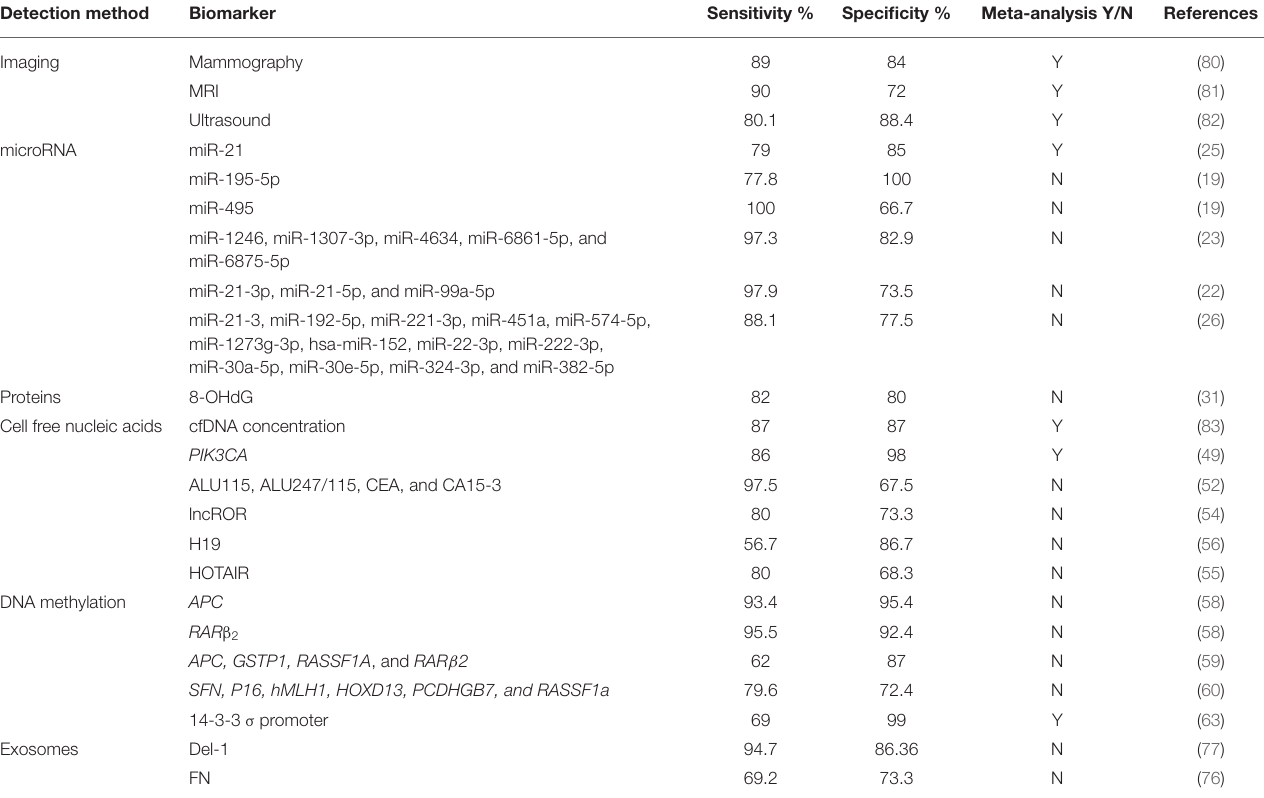
TABLE 1 | Sensitivities and specificities of different breast cancer detection methods (Imaging and blood-based biomarkers). Detection